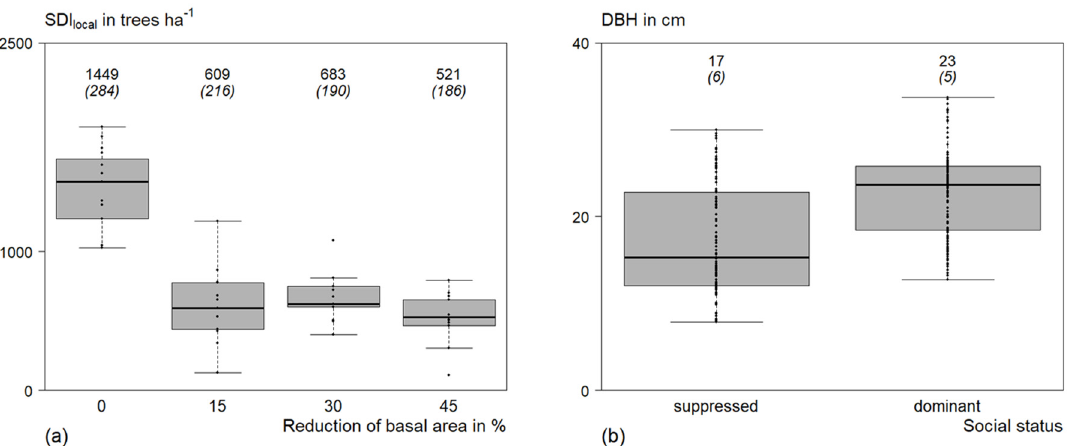
Figure 2. ( a ) The relationship between competition and thinning regime. ( b ) The relationship be ‐ tween DBH and social status. Mean value and standard deviation (italic and in brackets) are given.